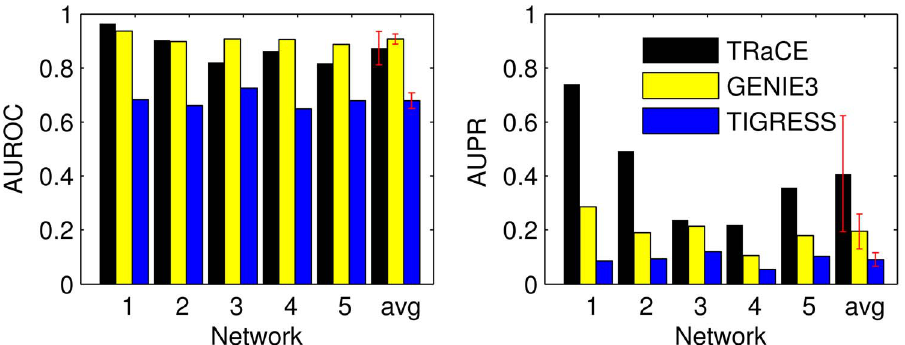
Figure 10. Comparison of TRaCE and top performing methods in DREAM4 100-gene network inference subchallenge: single- and double-gene KO dataset. The error bars represent the standard deviations. Based on the AUROC values, TRaCE performed as well as GENIE3 ( p ~ 0 : 8 ) and better than TIGRESS ( p ~ 0 : 0005 ). Similarly, based on the AUPR values, TRaCE performed better than GENIE3 ( p ~ 0 : 04 ) and TIGRESS ( p ~ 0 : 01 ). The statistical significance was evaluated using two sample t-test.